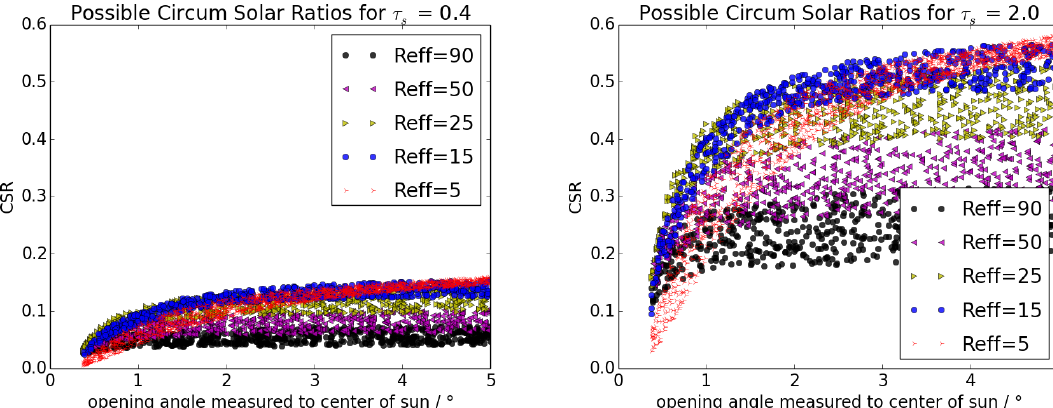
Fig. 2. Possible circumsolar ratio (CSR) values as a function of the limiting angle α for a variety of cirrus clouds, each composed of a random mixture of the five particle shapes and the two particle mixtures (described in Sect. 2.3). Left: τ s = 0 . 4. Right: τ s = 2 . 0. Different symbols denote different effective radii (labelled Reff, units µm).